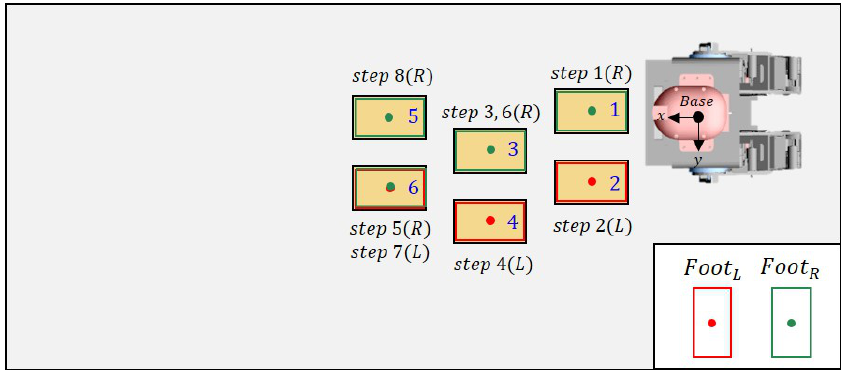
Figure 16. Top view of Scene 2.